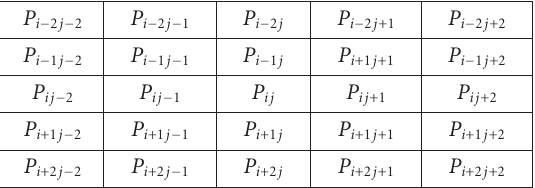
Table 2: 25 pixels centered p ij for computing D ij